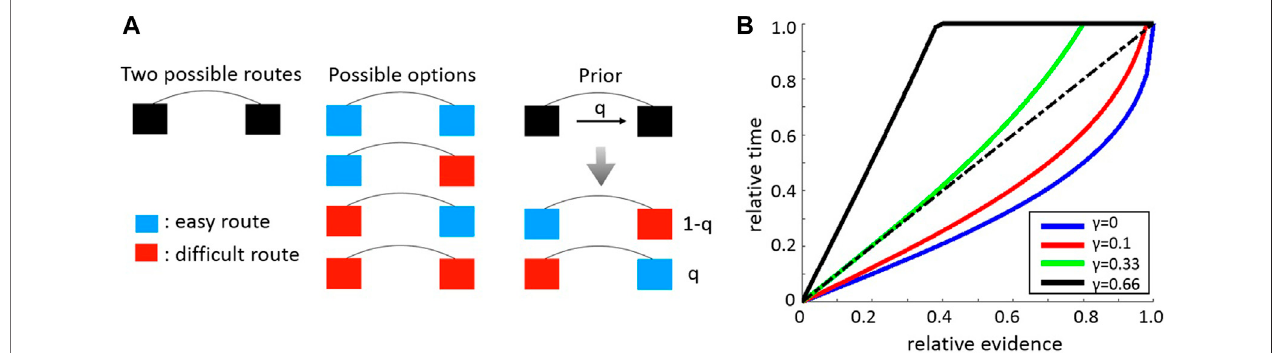
FIGURE5| Abstractobstaclecircumventionmodel. (A) .Themodeldescribesanobstaclewhichcanbecircumventedusingtwoseparateroutes(blacksquareson left hand column) each of which can offer either easy (blue) or dif fi cult (red) traversal. There are therefore exactly four distinct obstacle combinations (central column). Circumvention time for symmetric obstacles is independent of strategy. However, for asymmetric obstacles (right hand column) an optimal circumvention strategy depends on external information encoded by the parameter q which speci fi es the probability that the easily traversable path is on the right. (B). Optimal time balancingstrategies. Therelativedifference inthetime invested inoneoftheroutesasafunctionoftherelative evidenceindicatingittobetheeasyroute. Differentcolors signifydifferent valuesofthe parameter c (cid:1) p diff / p easy ,the ratiobetween thetraversal ef fi ciencyfor thetworoutes. c (cid:1) 0corresponds tothecase where only oneroute is traversable (equivalent to the key search example, see text) and displays sub-linear behavior: even very small evidence toward one route dictates large search times in that direction. Increasing the value of γ leads to super-linear behavior where low evidence towards a route dictates little to no search time invested there.